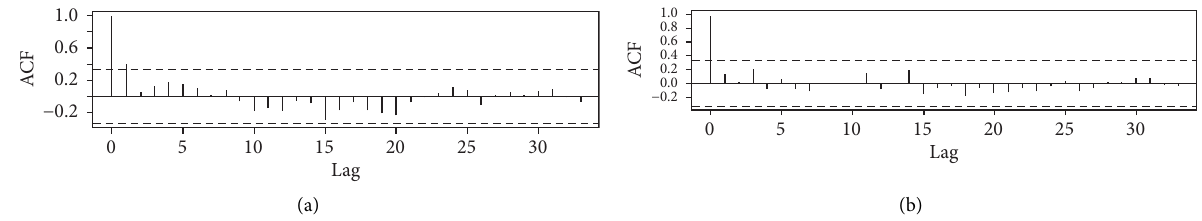
Figure 5: Autocorrelation of long-term areal annual rainfall and maximum temperature of Arfide, South Omo Ethiopia (period: 1983–2016). ACF � autocorrelation function; Lag � number of years considered during the time series analysis. (a) Annual rainfall. (b) Annual maximum